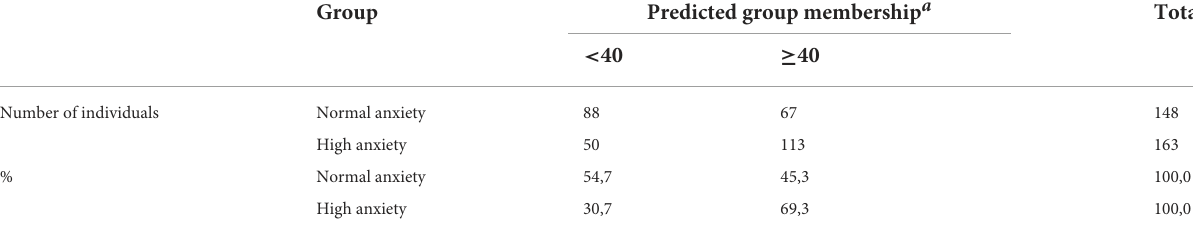
TABLE 4 Ranking of discriminant analysis results for fermented foods consumed by subjects divided into two groups: STAI score < 40 and STAI score ≥